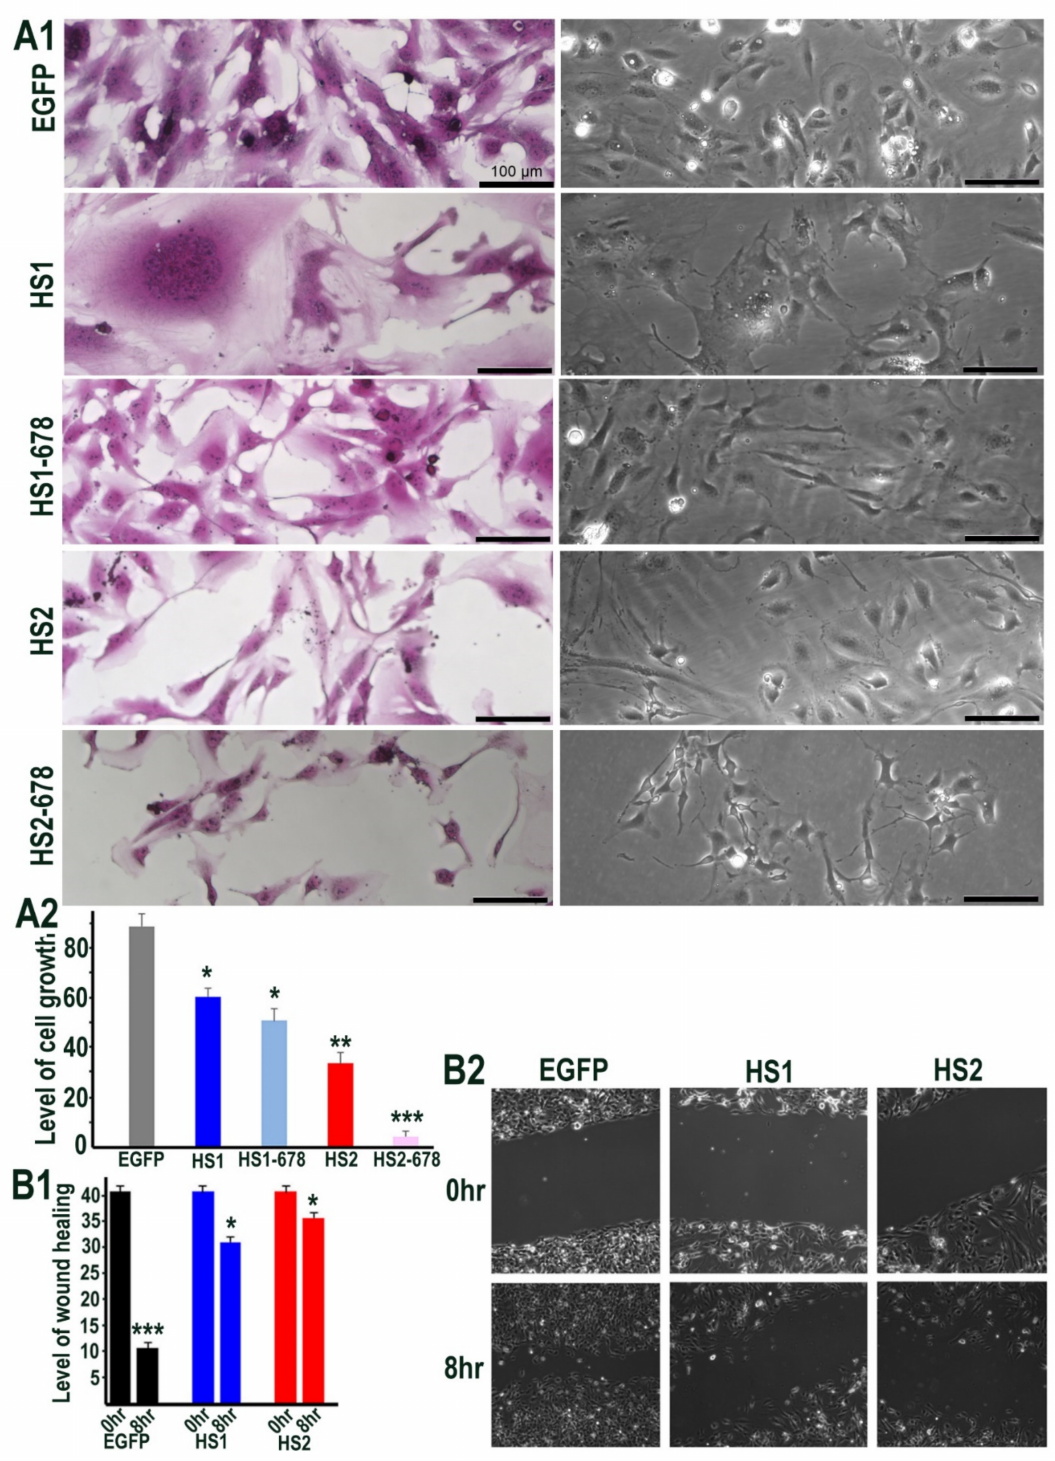
Figure 4. ( A1 ) Cell morphology of HMec1 cells transfected with EGFP, HS1 (full length Sulf1), HS1- 678 (shorter inactive Sulf1), HS2 (full length Sulf2), HS2-678 (shorter inactive Sulf2) examined by phase contrast microscopy of cells (right lane) and photographing cells following staining with SRB dye (left lane). Scale bar: 100 µ M. ( A2 ) represents the changes in cell proliferation or relative cell mass of transfected and control cells following absorbance measurements of SRB stain at OD 565 nm. ( B1 , B2 ) represent the changes in wound healing/cell migration in control (EGFP) versus Sulf1 (HS1) and Sulf2 (HS2) transfected cells. Error bars = means ± SD; *** p < 0.0001; ** p < 0.001; * p <